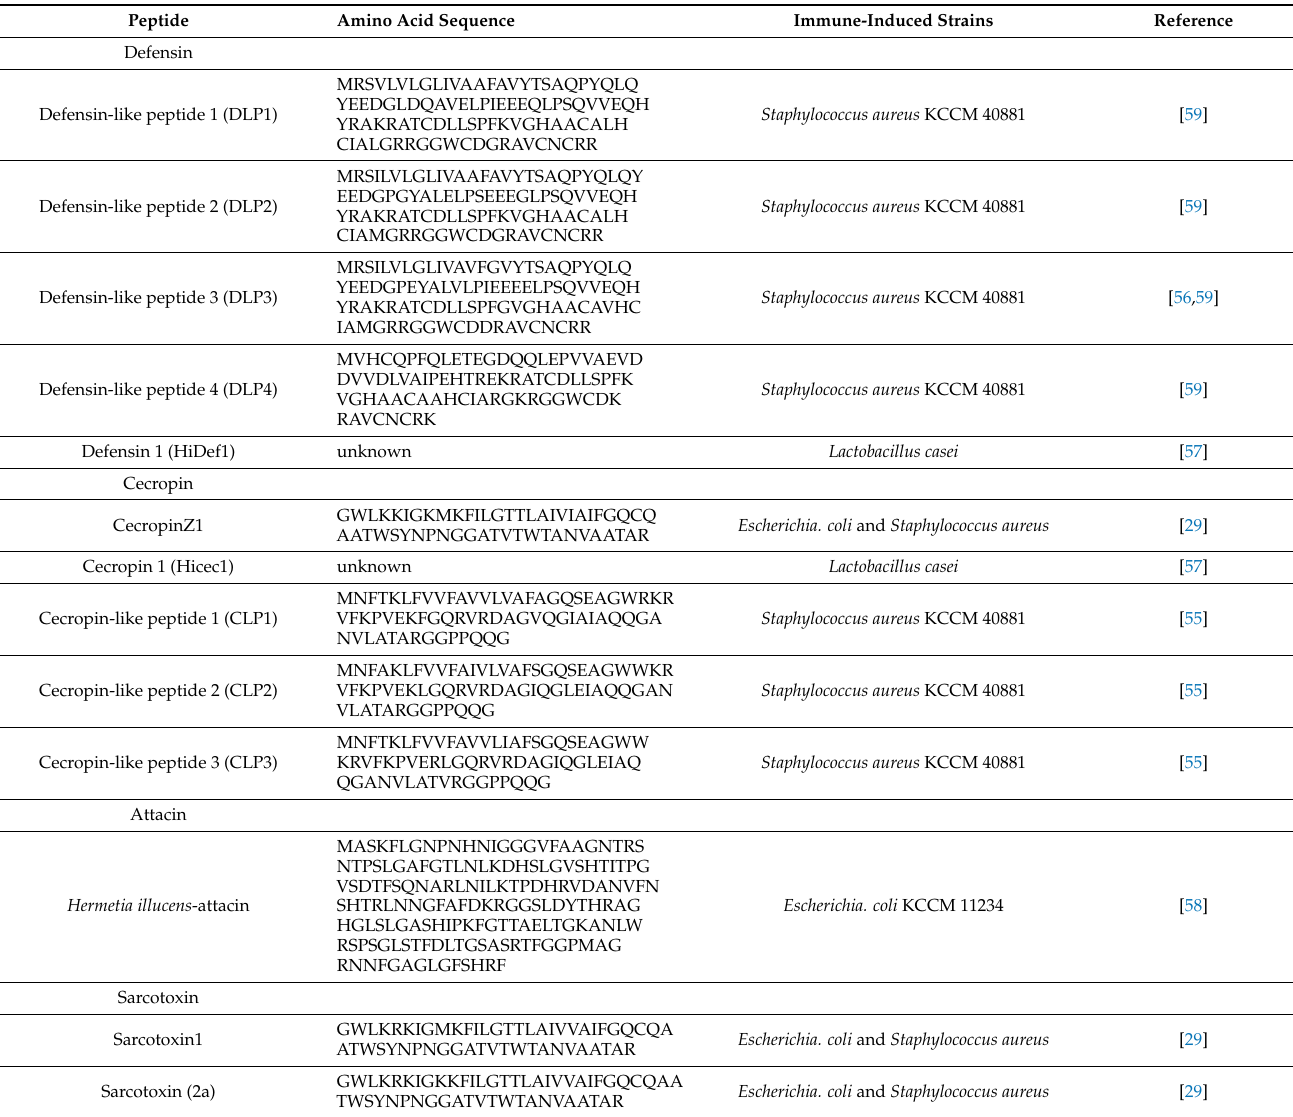
Table 1. Antimicrobial peptides from Hermetia illucens